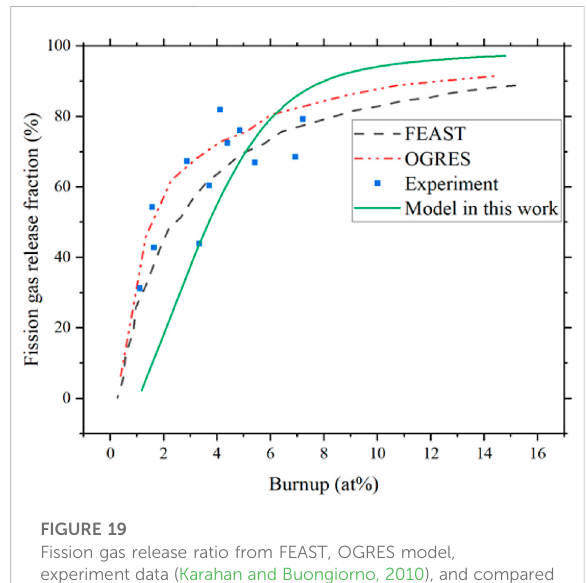
FIGURE 19 Fission gas release ratio from FEAST, OGRES model, experiment data (Karahan and Buongiorno, 2010), and compared with model in this